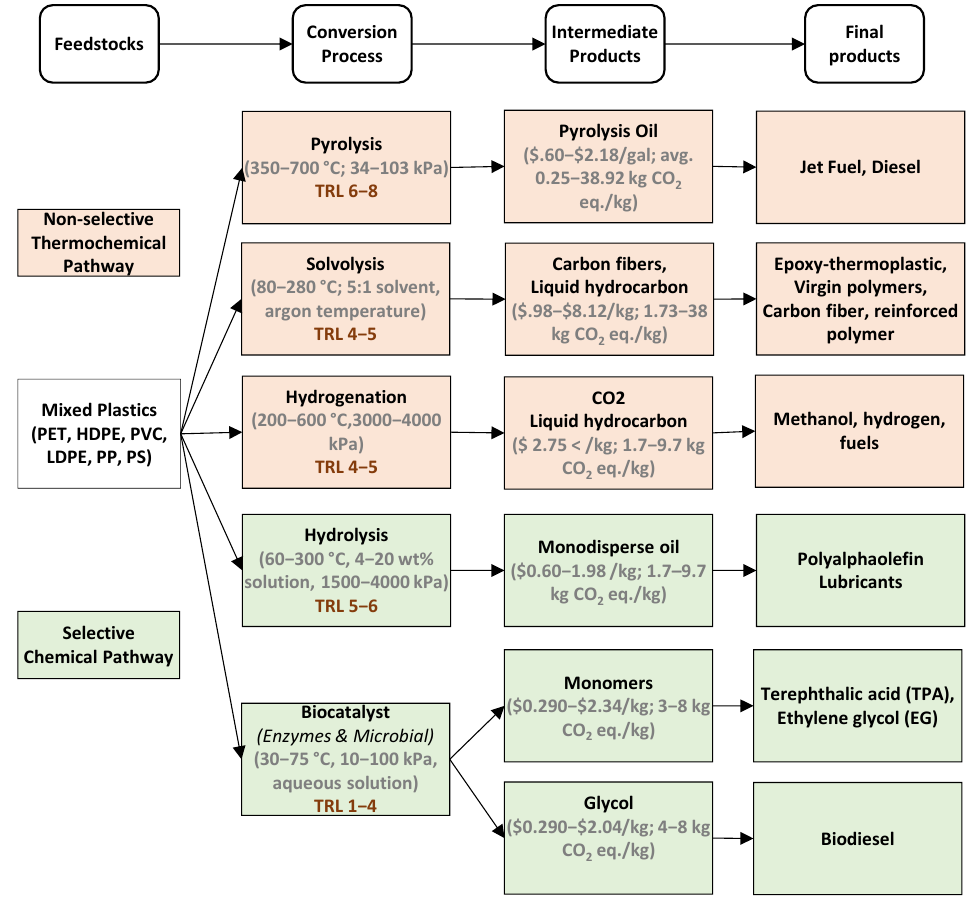
Figure 1. Fuel conversion pathways from plastic wastes.